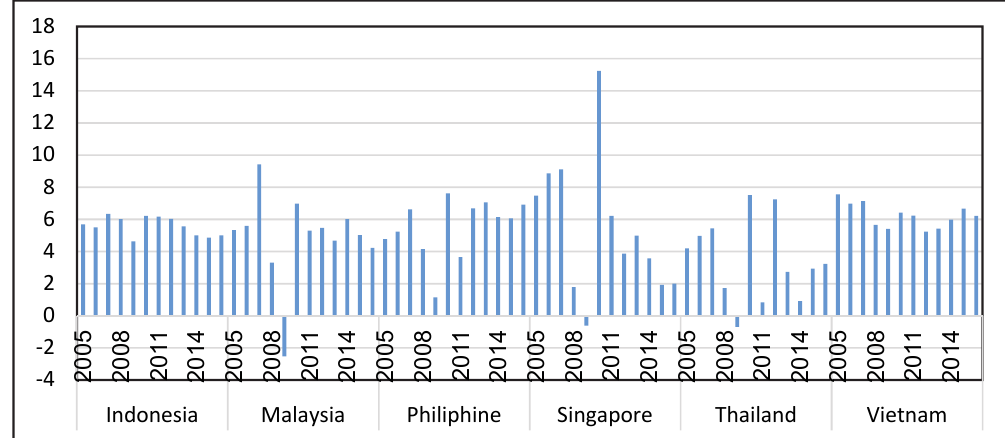
Fig. 1. The Percentage of ASEAN’S